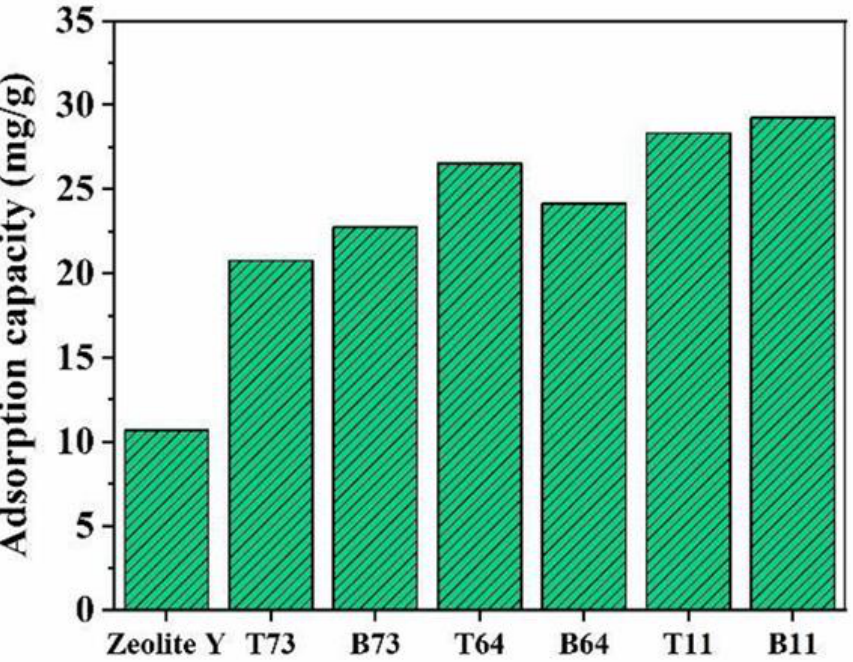
Figure 12. The adsorption capacity of micro and